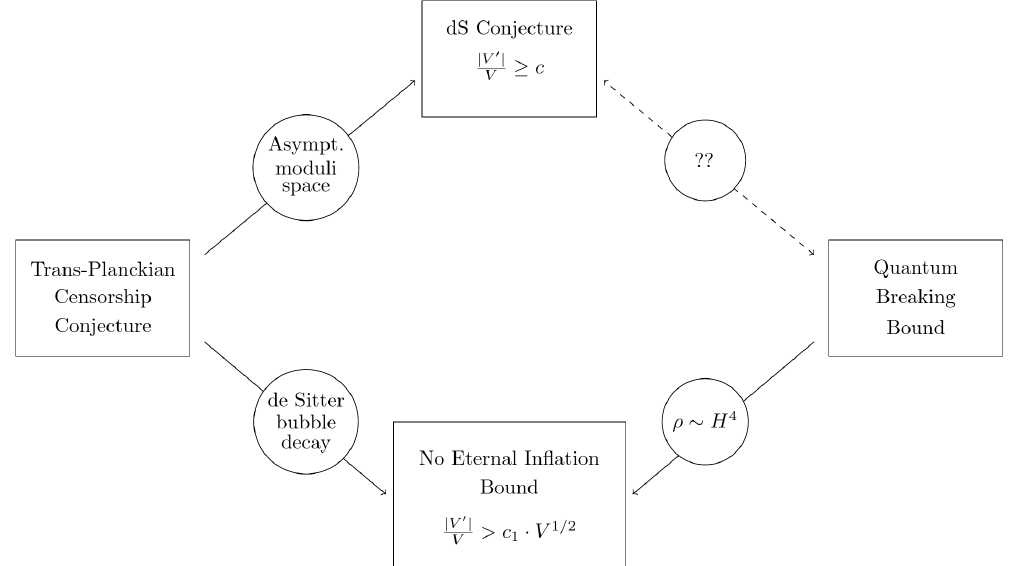
Figure 1 . Schematic depiction of bounds for | V 0 | /V for a (positive) scalar potential V in 4D and their origin in terms of swampland conjectures or avoidance of the quantum breaking. c, c positive O (1)